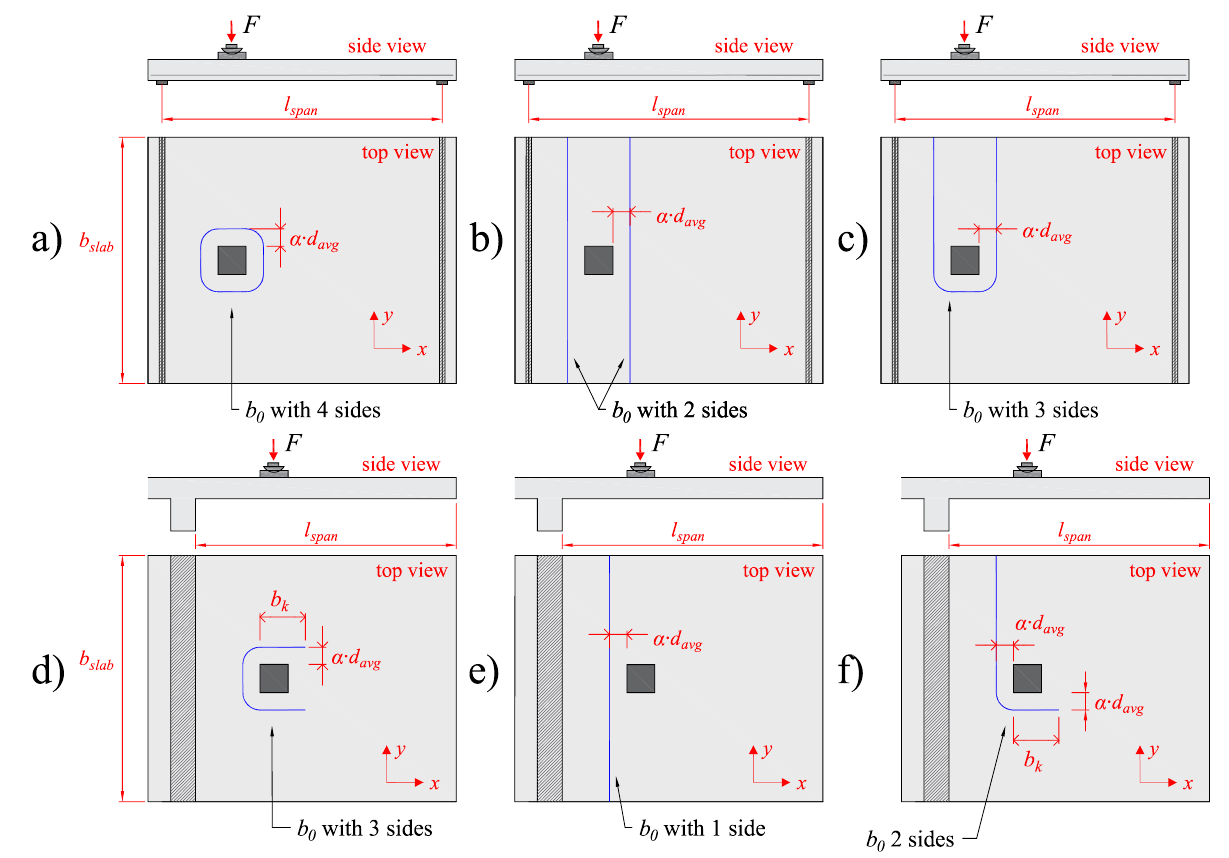
Figure 10. Different layouts of the control perimeter for simply supported slabs: ( a ) four sides, ( b ) two sides and ( c ) three sides; and for cantilever slabs: ( d ) three sides, ( e ) one side and ( f ) two sides.